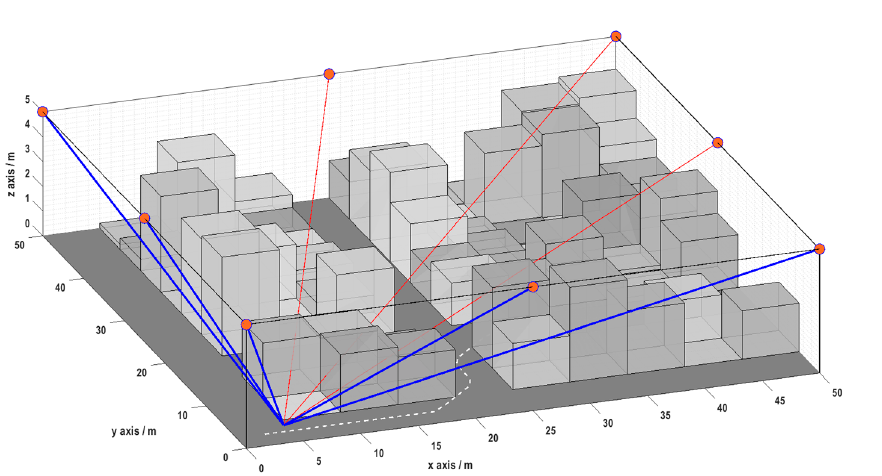
Figure 5. Schematics for the infrared receiver validation check. Five blue infrared beams together with corresponding receivers are valid because they are not occluded by the cargoes.